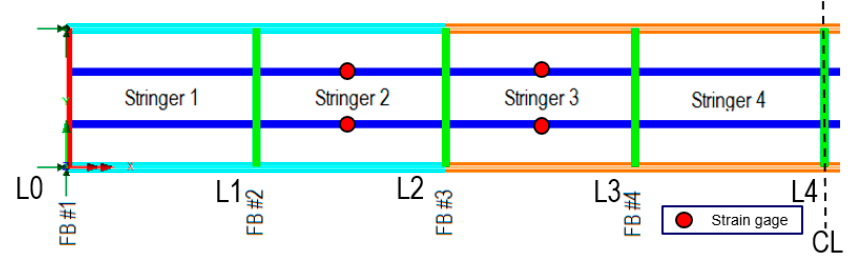
Figure 14. Gauge locations in stringers.